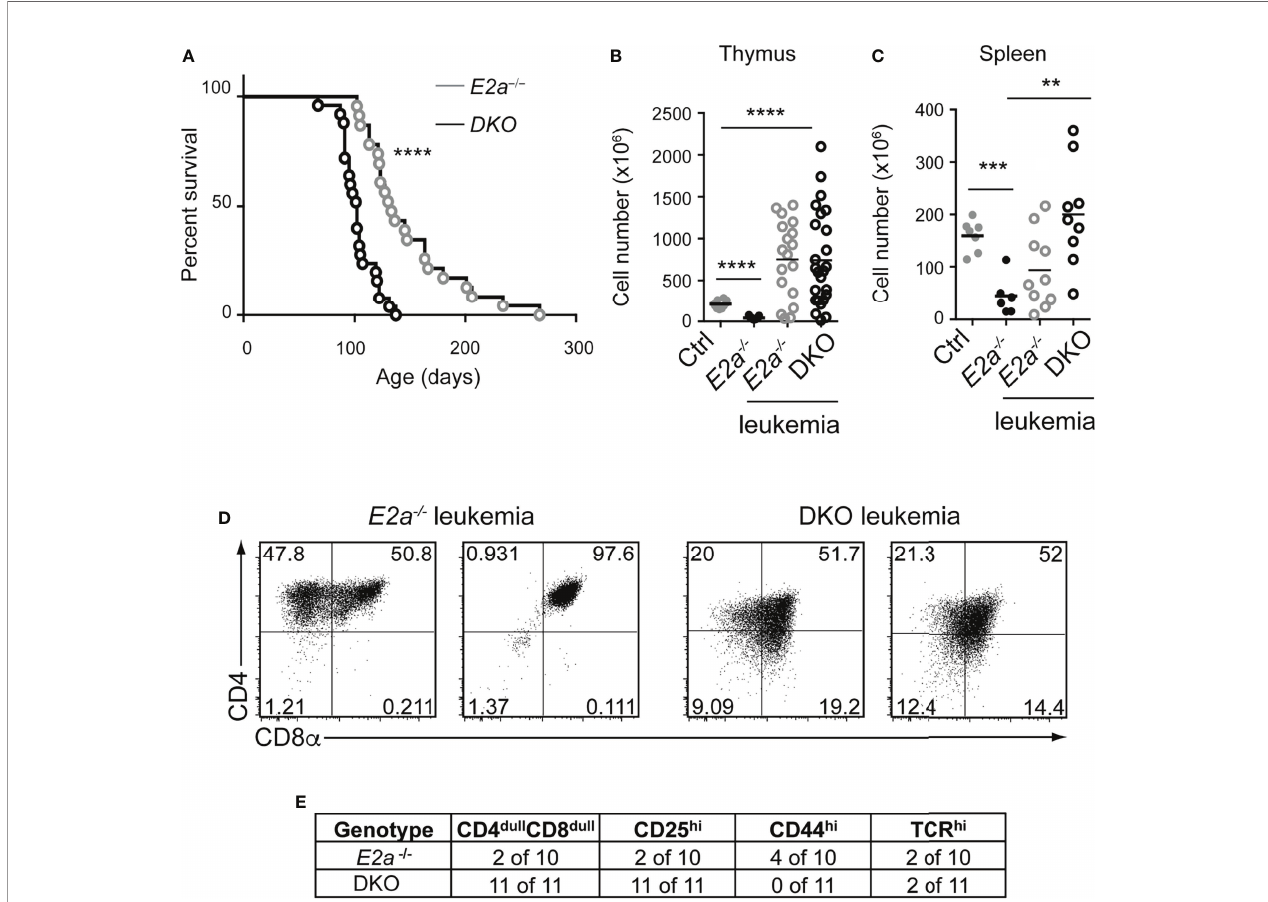
FIGURE 5 | DKO mice have an accelerated onset of T cell leukemia. (A) Kaplan-Meier plot of leukemia incidence in E2a -/- and DKO mice. ****p < 0.0001, Mantel- Cox Test (B) Total thymocyte numbers and (C) spleen lymphocyte numbers at time of morbidity in E2a -/- and DKO mice compared to age matched Ctrl and non- moribund E2a -/- mice. ** p< 0.01, ***p < 0.005, ****p < 0.001. Student ’ s t-test for pairwise comparisons. (D) Flow cytometry showing CD4 and CD8 on two representative E2a -/- and DKO thymic leukemias. (E) Summary of phenotype of E2a -/- and DKO